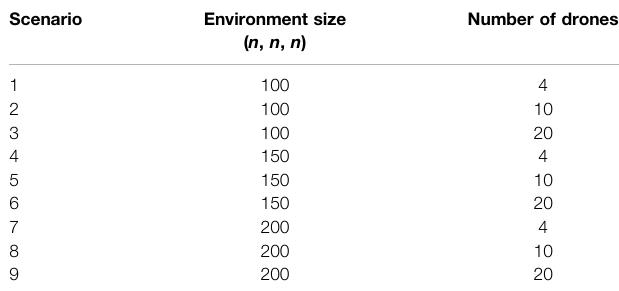
TABLE 4 | Test plan scenarios. The environment size, n , is measured in non- dimensional